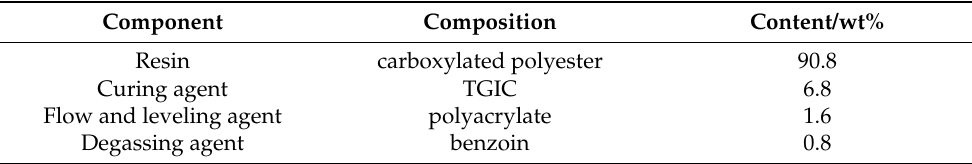
Table 2. Binder formula of polyester/TGIC powder clearcoat